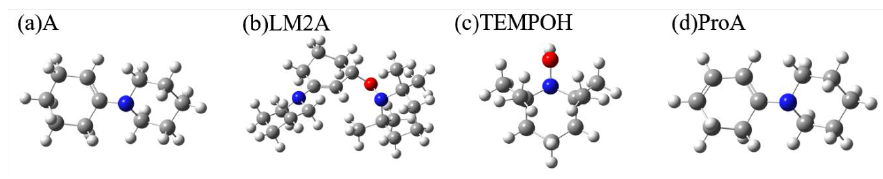
Figure 2. Calculated geometries of ( a ) reactant A, ( b ) β -aminoxylated intermediate LM2A, ( c ) TEMPOH and ( d ) amino diene intermediate ProA.